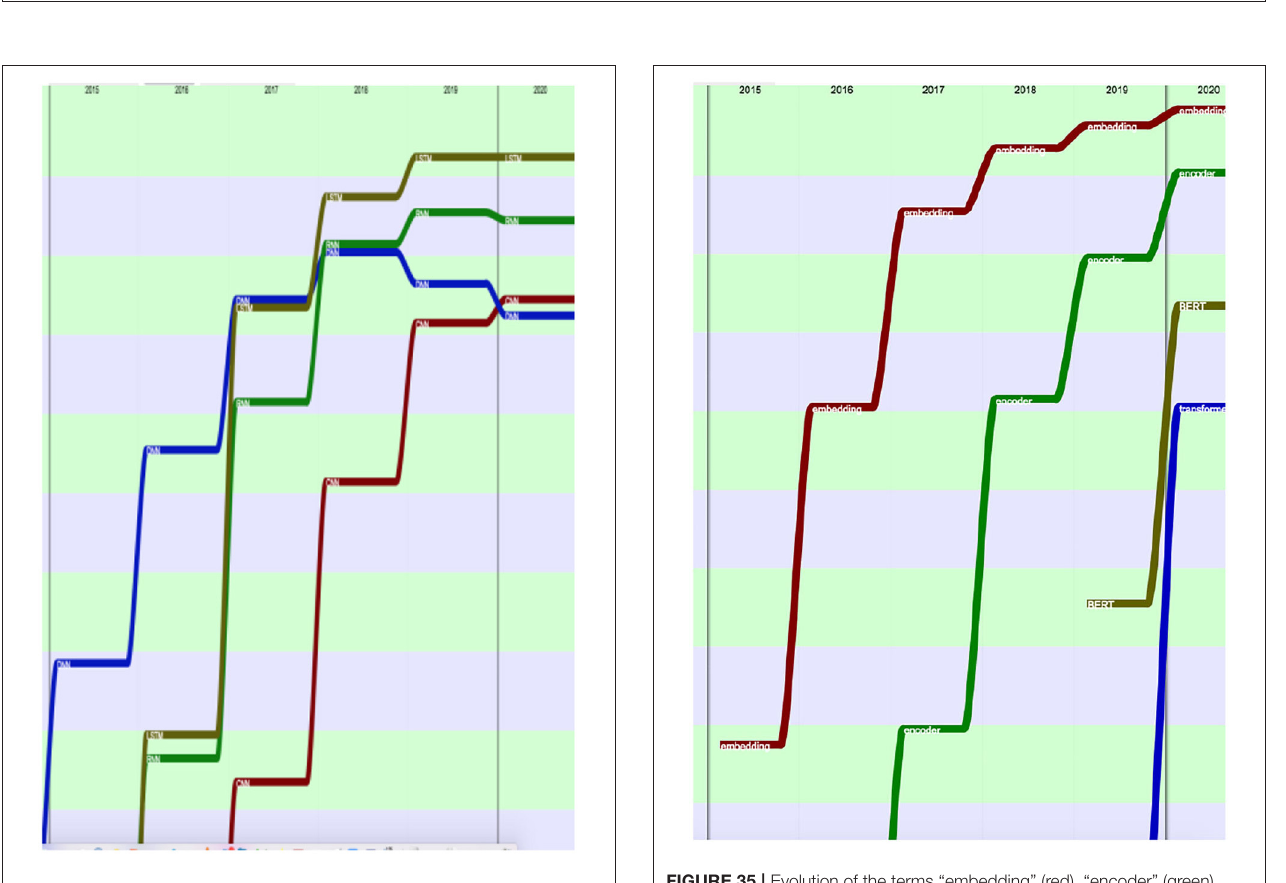
FIGURE 34 | Evolution of the terms “LSTM” (brown), “RNN” (green), “DNN” (blue) and “CNN” (red) over the past 5 years (from the 100th rank in 2015 to the 30th in 2020), according to their presence.